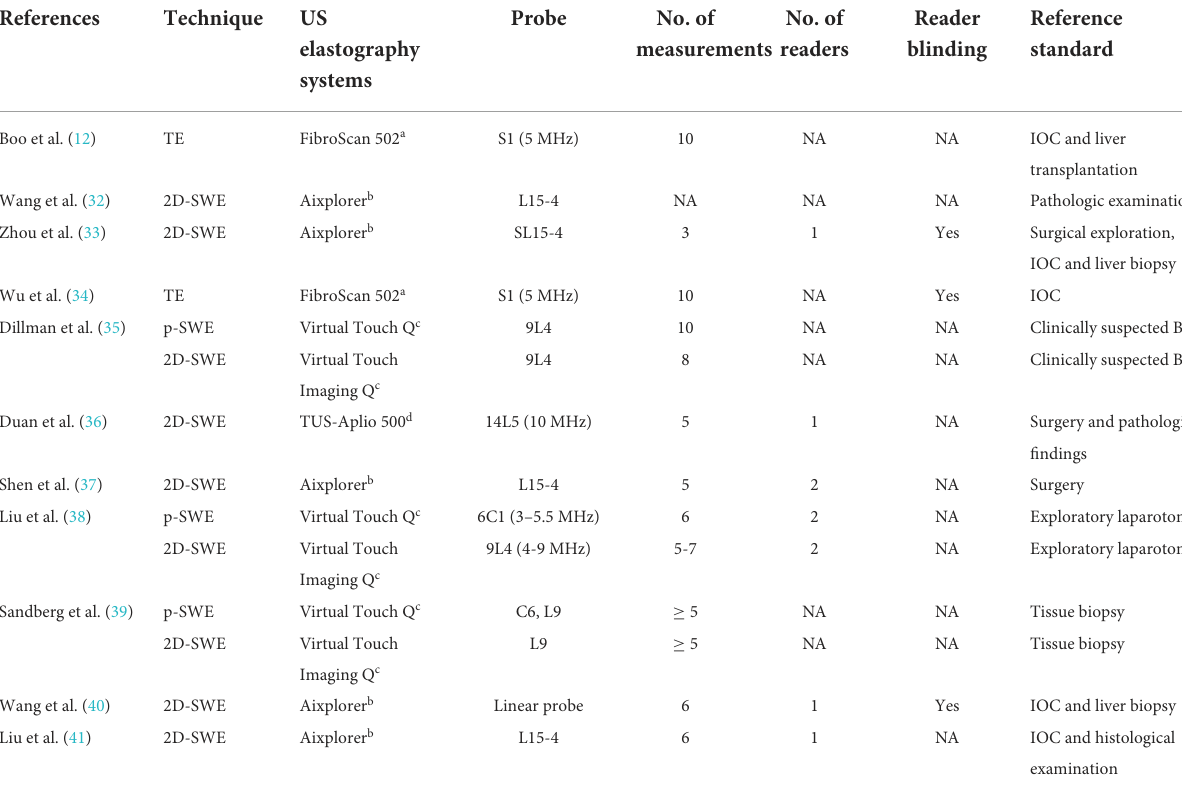
TABLE 2 Characteristics of ultrasound elastography